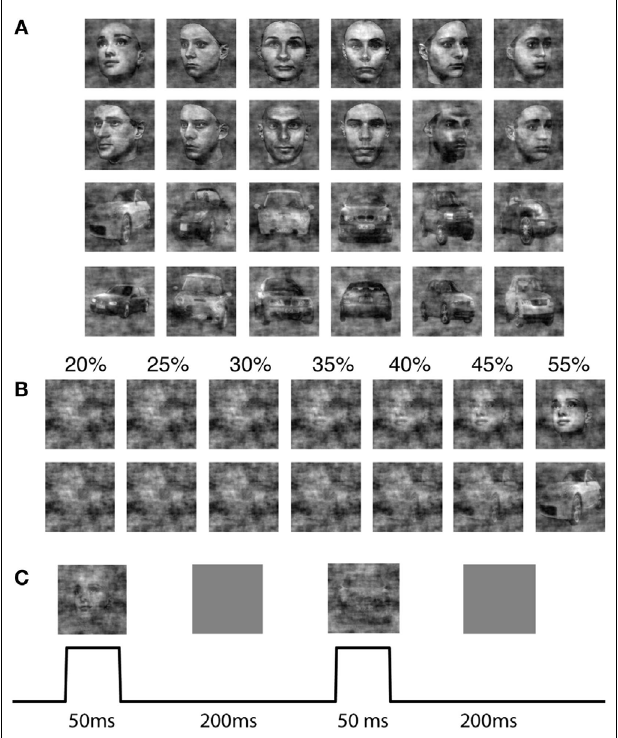
FIGURE 1 |The stimulus set for the 2-AFC perceptual decision making task. (A) Shown are 12 face and 12 car images at phase coherence 55%. (B) One sample face and one sample car image, at phase coherences varying from 20 to 55%. (C) Design and timing of the simulated psychophysics experiment for the